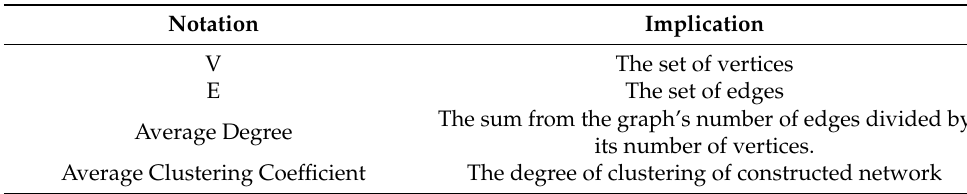
Table 2. The Notations of basic network topological